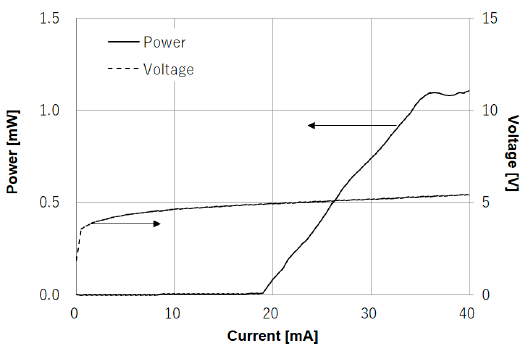
Figure 3. Cross-sectional scanning electron microscopy (SEM) image of the epitaxial lateral overgrowth (ELO) structure, in which the n-side DBR is engulfed in n-GaN grown using the ELO process. The flat surface of the epitaxial layer forms a 4.5-mm-long cavity.